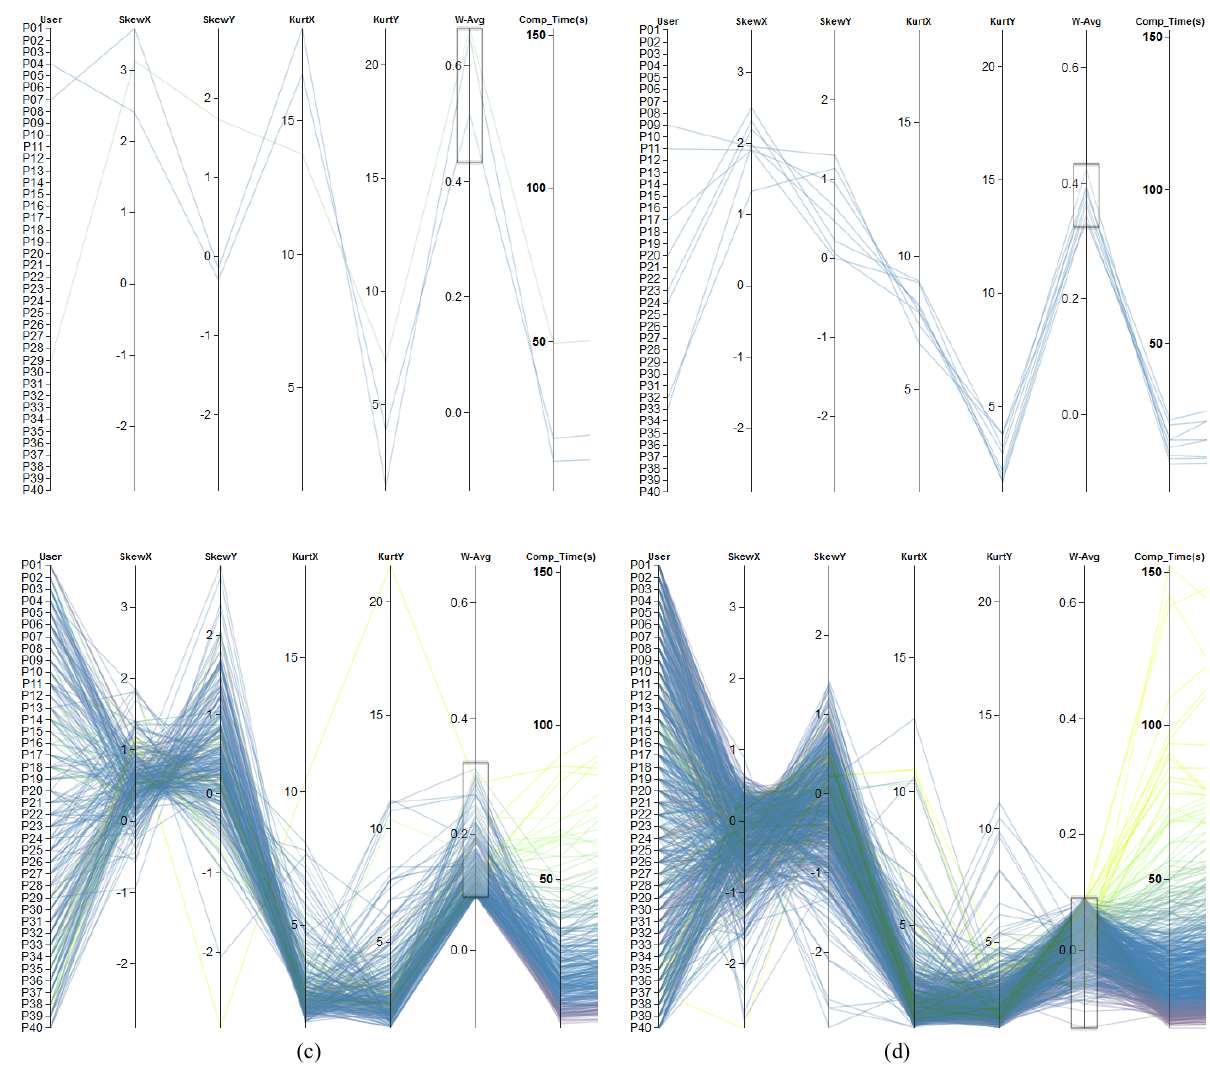
Figure 12 . Combination of four metrics ( SkewX, SkewY, KurtosisX, and KurtosisY ). Color encoding is based on the clustering according to completion time . The four images show a rough categorization of the participants into four groups. Metrics values in (a) show large changes between neighboring axes, whereas in (b) there is a visible drop-off in changes. Images (c) and (d) indicate same values with respect to kurtosis but differ in SkewY . The weight for skewness was set to 0.3, whereas 0.7 was assigned to kurtosis-related